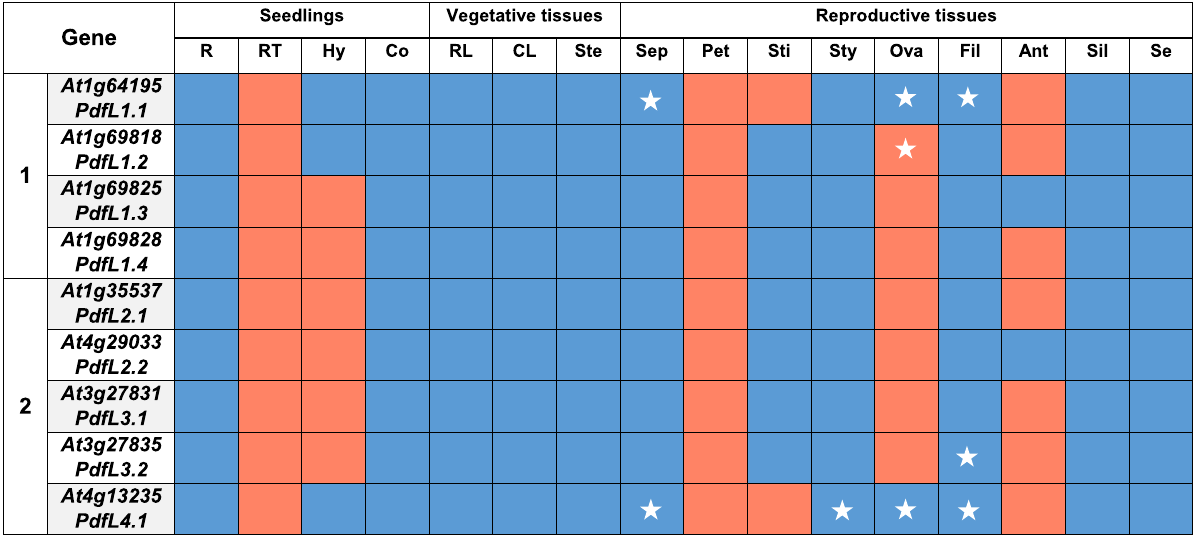
Table 2. Comparison of the activity of the promoters of 9 PdfL genes in different plant tissues. Blue indicates expression and red indicates no expression. White stars indicate a different expression pattern than others: PdfL1.1 and PdfL4.1 are expressed only in the veins of sepals. The promoter of PdfL4.1 is only active in the vascular tissue of the style. The PdfL1.1 promoter has weak activity throughout the ovary and also in the vascular tissues while the promoter of PdfL4.1 is active in the vascular tissue of the ovary. The promoter of PdfL1.2 has no activity in the ovary while activity of the promoters of other PdfLs is restricted activity to the upper part of the ovary connected to the style. Activity of the promoters of PdfL1.1 and PdfL4.1 was stronger in the vascular tissue of the filament than the other tissues and the activity of the PdfL3.2 promoter was restricted to the